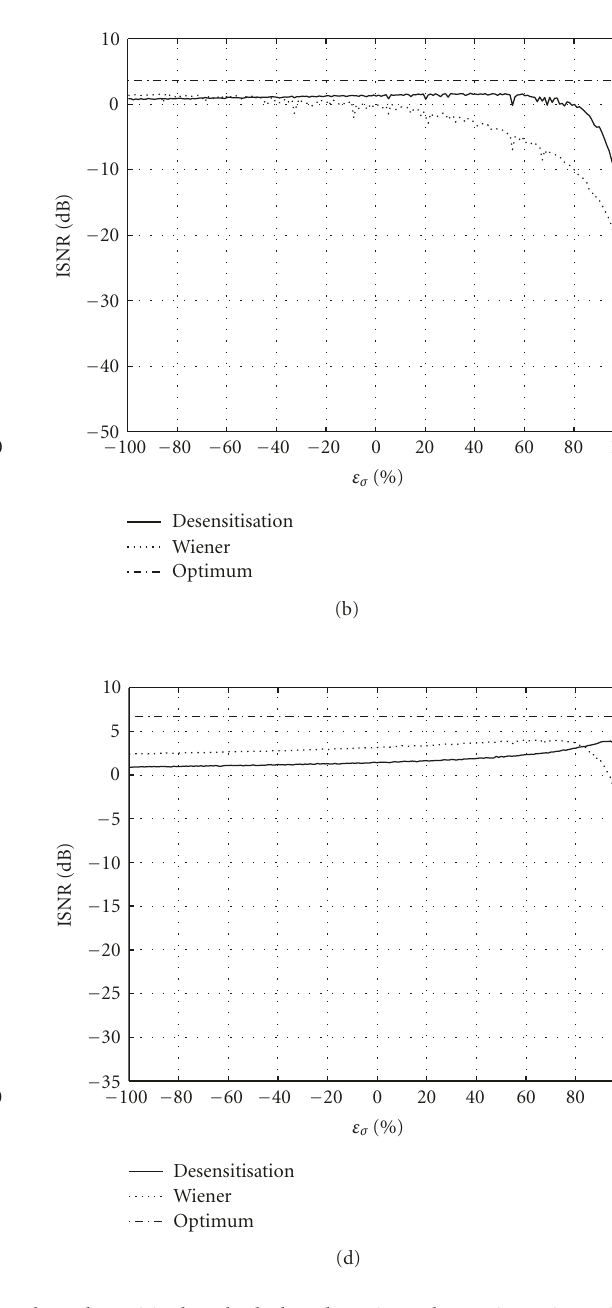
Figure 6: Distributions of ISNR obtained by both the Wiener filter and our desensitised method when the estimated Gaussian noise variance is altered according to a relative error ε σ leaving the PSF estimation unchanged (motion blur). Di ff erent noise levels are applied in relation to a BSNR of (a) 0dB, (b) 10 dB, (c) 20 dB, and (d) 30 dB . Besides, a horizontal line is included symbolizing the constant value of ISNR reached when optimum estimates are considered in the Wiener